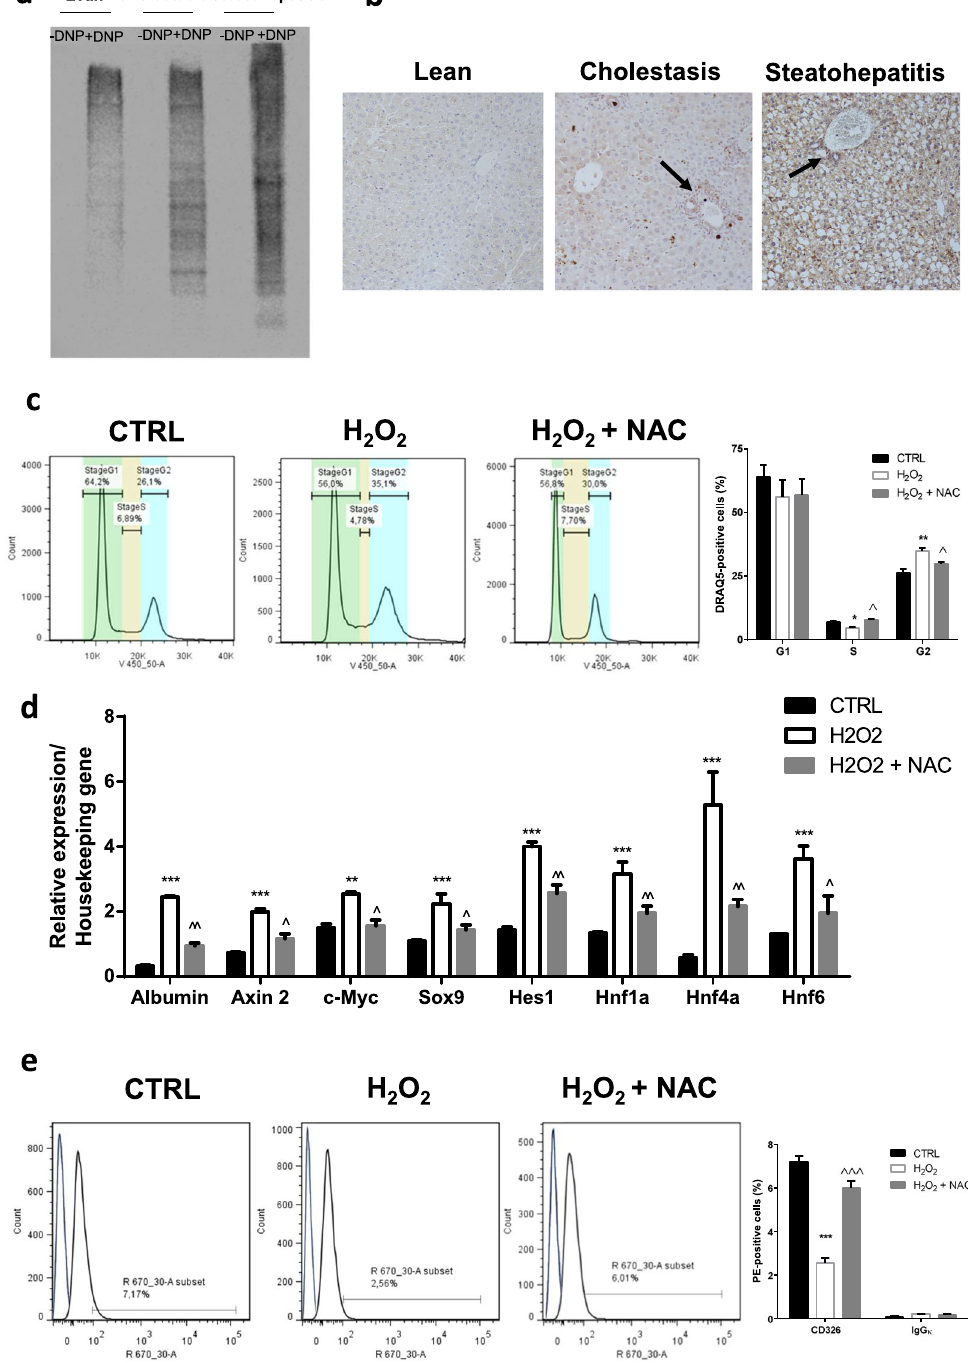
Fig. 1 HPCs are activated by oxidative stress. a Representative oxyblot analysis of liver homogenates from mice fed a control chow (lean), 3,5-diethoxycarbonyl-1,4-dihydrocollidine diet (cholestasis), or methionine-choline-de fi cient diet (steatohepatitis); DNP dinitrophenylhydra- zine. b Representative images showing immunohistochemical detection of 4-hydroxy-2-nonenal (HNE) in the liver of mice fed a control chow (lean), 3,5-diethoxycarbonyl-1,4-dihydrocollidine diet (cholestasis), or methionine-choline de fi cient diet (steatohepatitis) (magni fi cation ×200). Black arrows indicate the portal tracts, where the canals of Hering are located. c Cell cycle analysis in BECs/HPCs exposed to 1 μ M H 2 O 2 or 1 μ M H 2 O 2 + 1 mM N -acetylcysteine (NAC) for 24 h. Data in the graph are represented as mean ± SEM of three independent experiments. Statistical differences were assessed by one-way ANOVA and Tukey – Kramer as post hoc test. * p < 0.05 vs CTRL; ** p < 0.01 vs CTRL; ^ p < 0.05 vs H 2 O 2 . d mRNA expression of Notch and Wnt pathway targets in BECs/HPCs exposed to 1 μ M H 2 O 2 or 1 μ M H 2 O 2 + 1 mM N -acetylcysteine (NAC) for 24 h. Data in the graph are represented as mean ± SD of three independent experiments. Statistical differences were assessed by one-way ANOVA and Tukey – Kramer as post hoc test. ** p < 0.01 vs CTRL; *** p < 0.001 vs CTRL; ^ p < 0.05 vs H 2 O 2 ; ^^ p < 0.01 vs H 2 O 2 . e Expression of EpCAM in BECs/HPCs exposed to 1 μ M H 2 O 2 or 1 μ M H 2 O 2 + 1 mM N -acetylcysteine (NAC) for 24 h. The blue line represents rat IgG isotype control antibody. Data in the graph are represented as mean ± SEM of three independent experiments. Statistical differences were assessed by one-way ANOVA and Tukey – Kramer as post hoc test. *** p < 0.001 vs CTRL; ^^^ p < 0.001 vs H 2 O 2